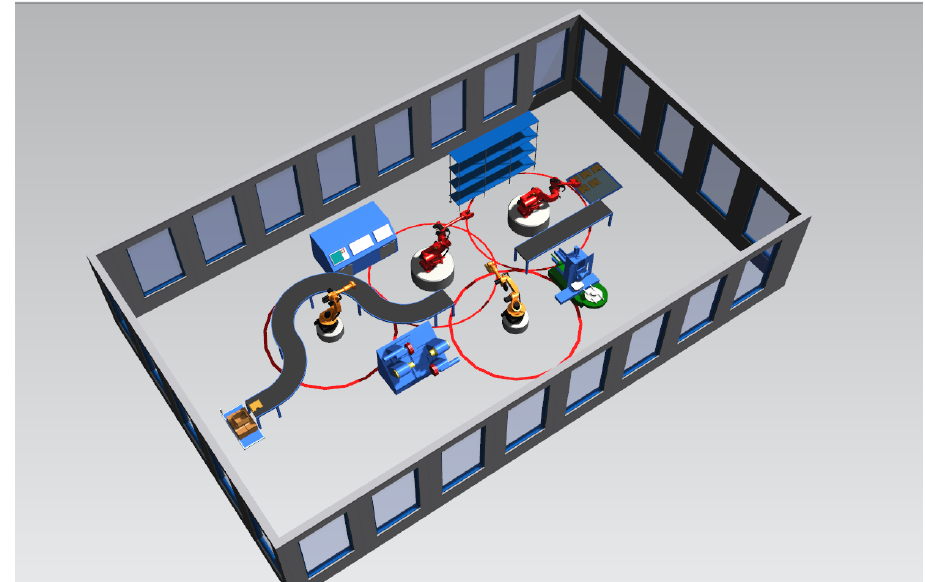
Figure 19. Possible architecture for small enterprises consists of storages, hybrid control, cognitive robots, CNC machines and laser quality